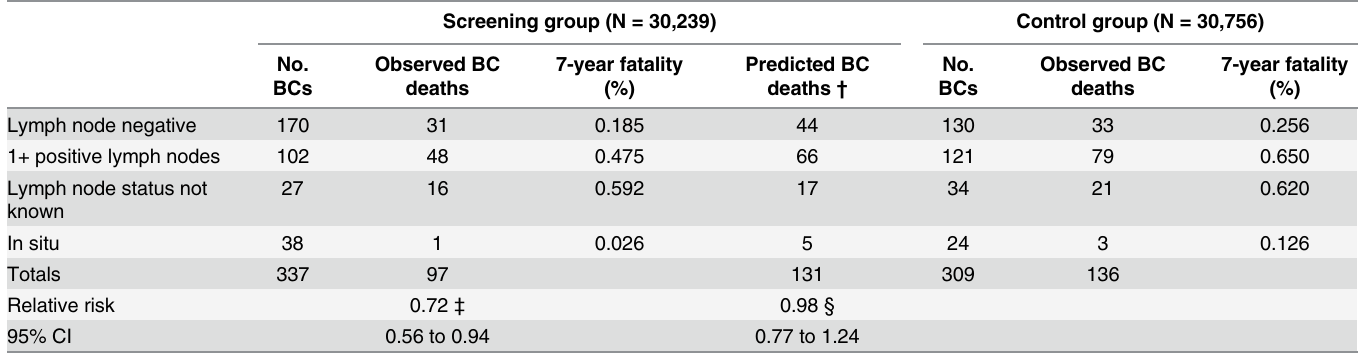
Table 3. Reported and predicted breast cancer deaths in the HIP trial *